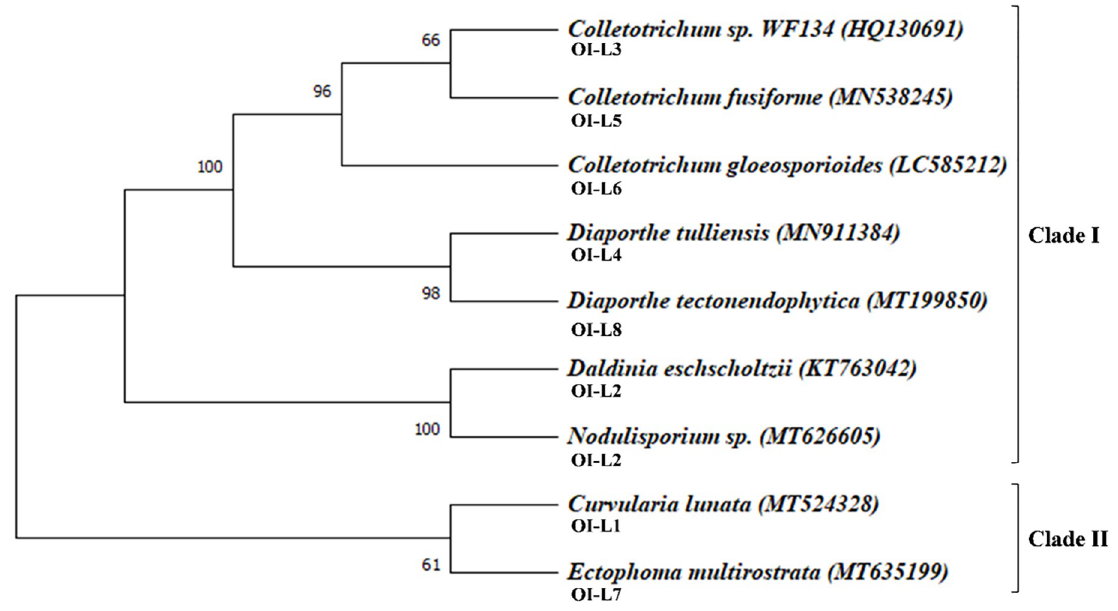
Fig 2. Phylogenetic tree of fungal endophytes constructed by maximum likelihood bootstrap (MLBS) method. The sequences were aligned through MUSCLE alignment program and the evolutionary history was inferred by using the Maximum Likelihood bootstrap (MLBS) method and General Time Reversible model.